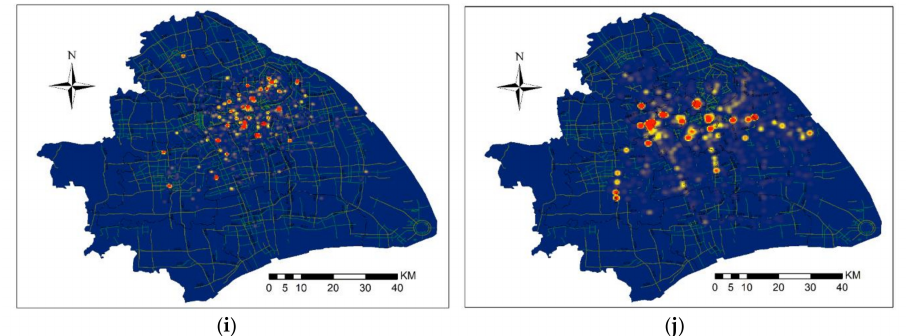
Figure 7. Category-wise density; ( a ) Educational; ( b ) Entertainment; ( c ) Food; ( d ) General_Location; ( e ) Hotel; ( f ) Professional; ( g ) Residential; ( h ) Shopping&Services; ( i ) Sport; and ( j )